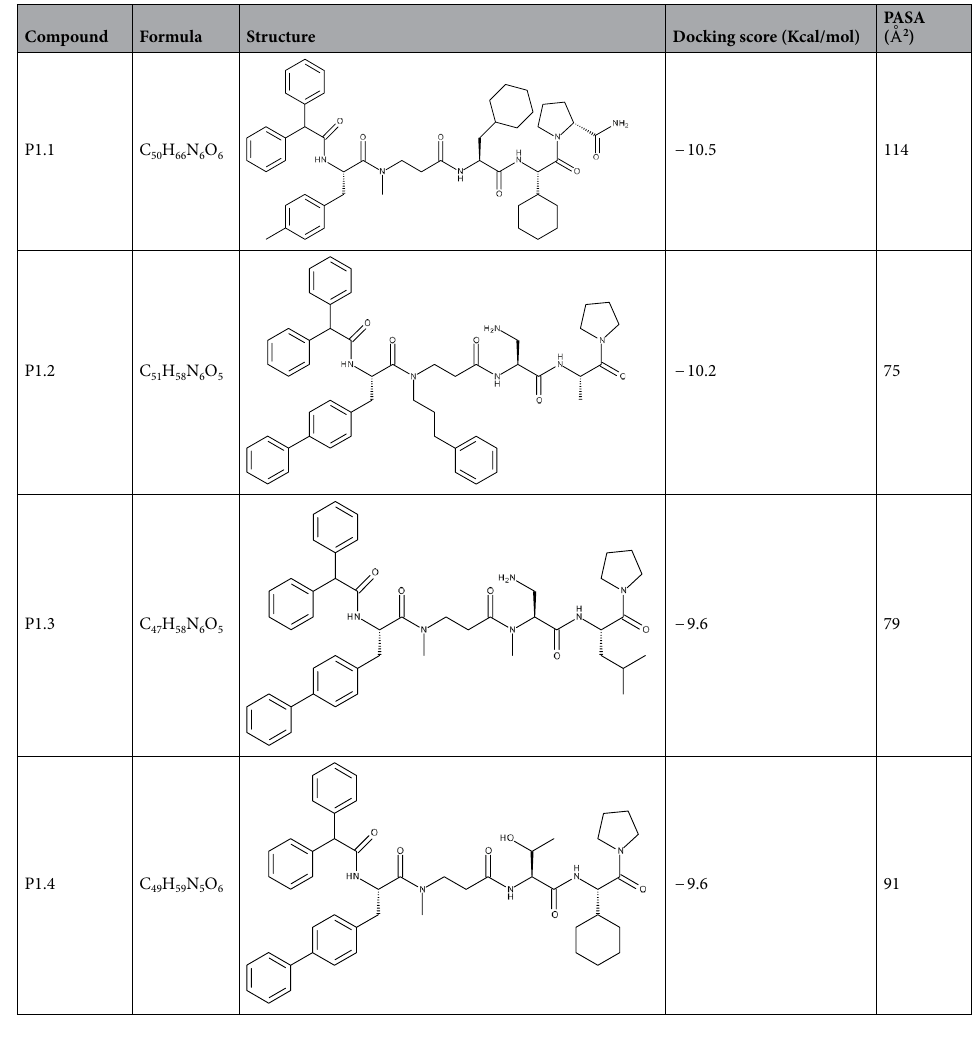
Table 3. Second set of inhibitors, docking scores and